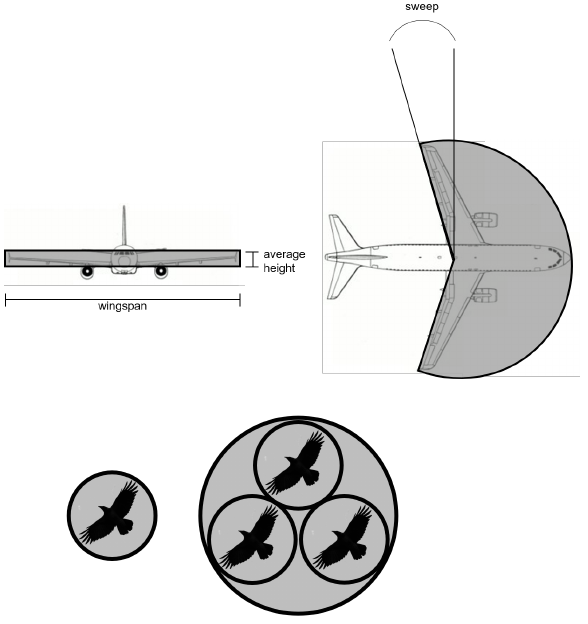
Figure 2. Protected volume of aircraft, individual birds and flocks (source: